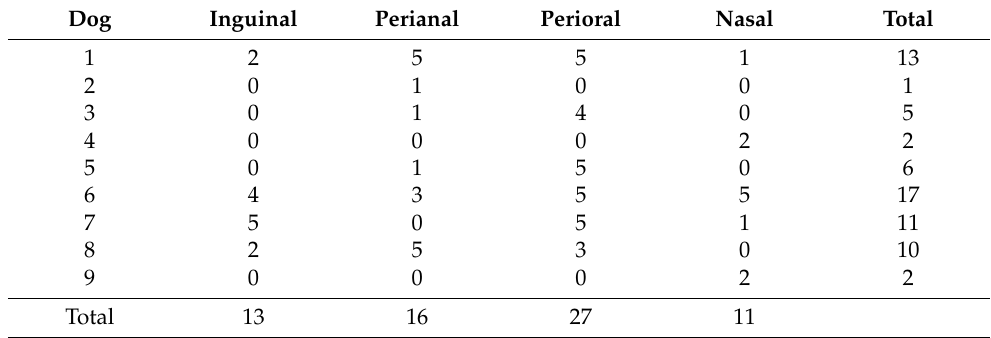
Table 1. Numbers and distribution of S. pseudintermedius isolates from four different sites in nine dogs. Dog Inguinal Perianal Perioral